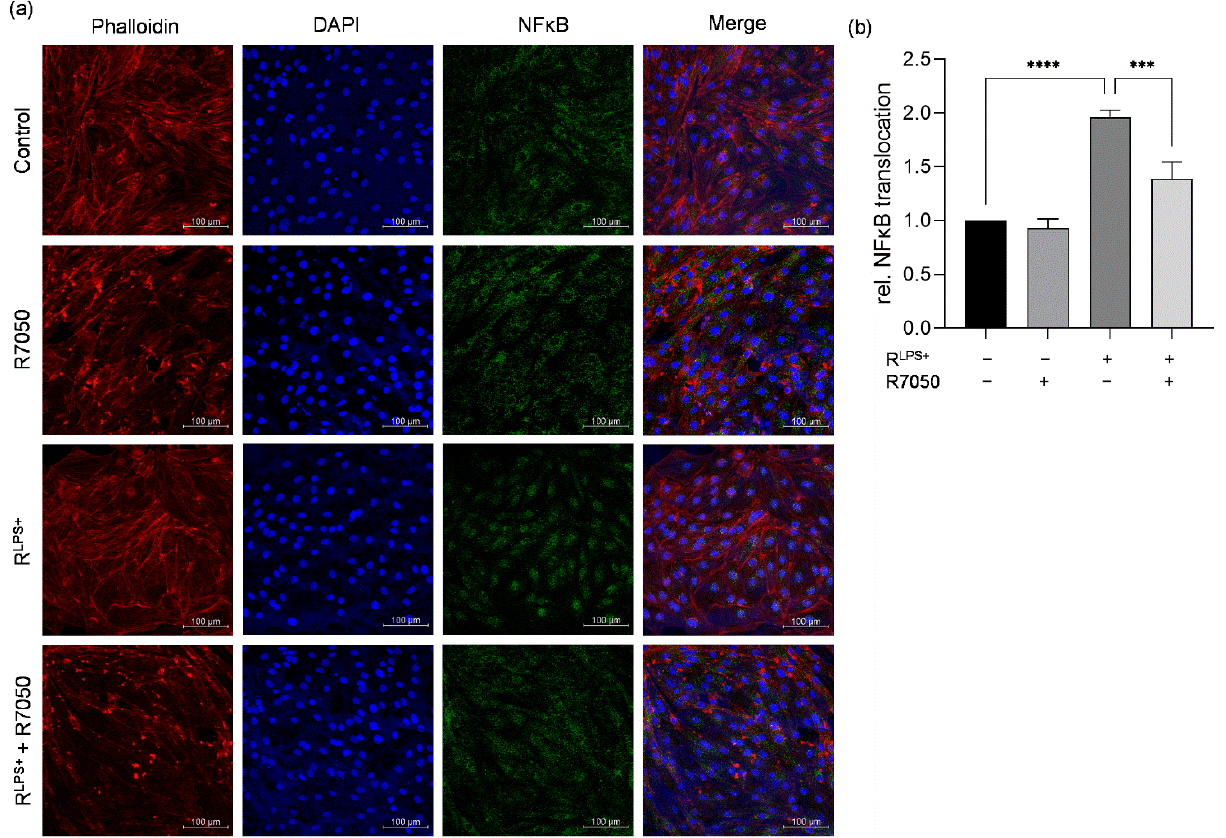
Figure 6. TNFR inhibition diminishes NF κ B translocation in cardiomyocytes exposed to conditioned medium of LPS-stimulated macrophages. ( a ) Cardiomyocytes exposed to conditioned medium of LPS-stimulated macrophages (R LPS+ ) for 30 min in the presence (R LPS+ + R7050) or absence of TNFR inhibitor (R7050) were stained with phalloidin-TRITC, DAPI, and anti-NF κ B and compared with unstimulated cells (n = 3). Phalloidin-TRITC was used to stain the cytoskeleton (red), and nuclei of the cardiomyocytes were stained with DAPI (blue). The green fluorescence indicates whether NF κ B is located in the cytoskeleton or is translocated into the nucleus. Scale bars: 100 µm. ( b ) Quantification of NF κ B translocation. One-way ANOVA followed by Tukey’s test was used for multiple comparisons. Data are presented as column bar graph as the mean ± SD. *** p < 0.001; **** p < 0.0001; LPS = lipopolysaccharide; TNFR = tumor necrosis factor receptor; NF κ B = nuclear factor kappa-light-chain-enhancer of activated B-cells.